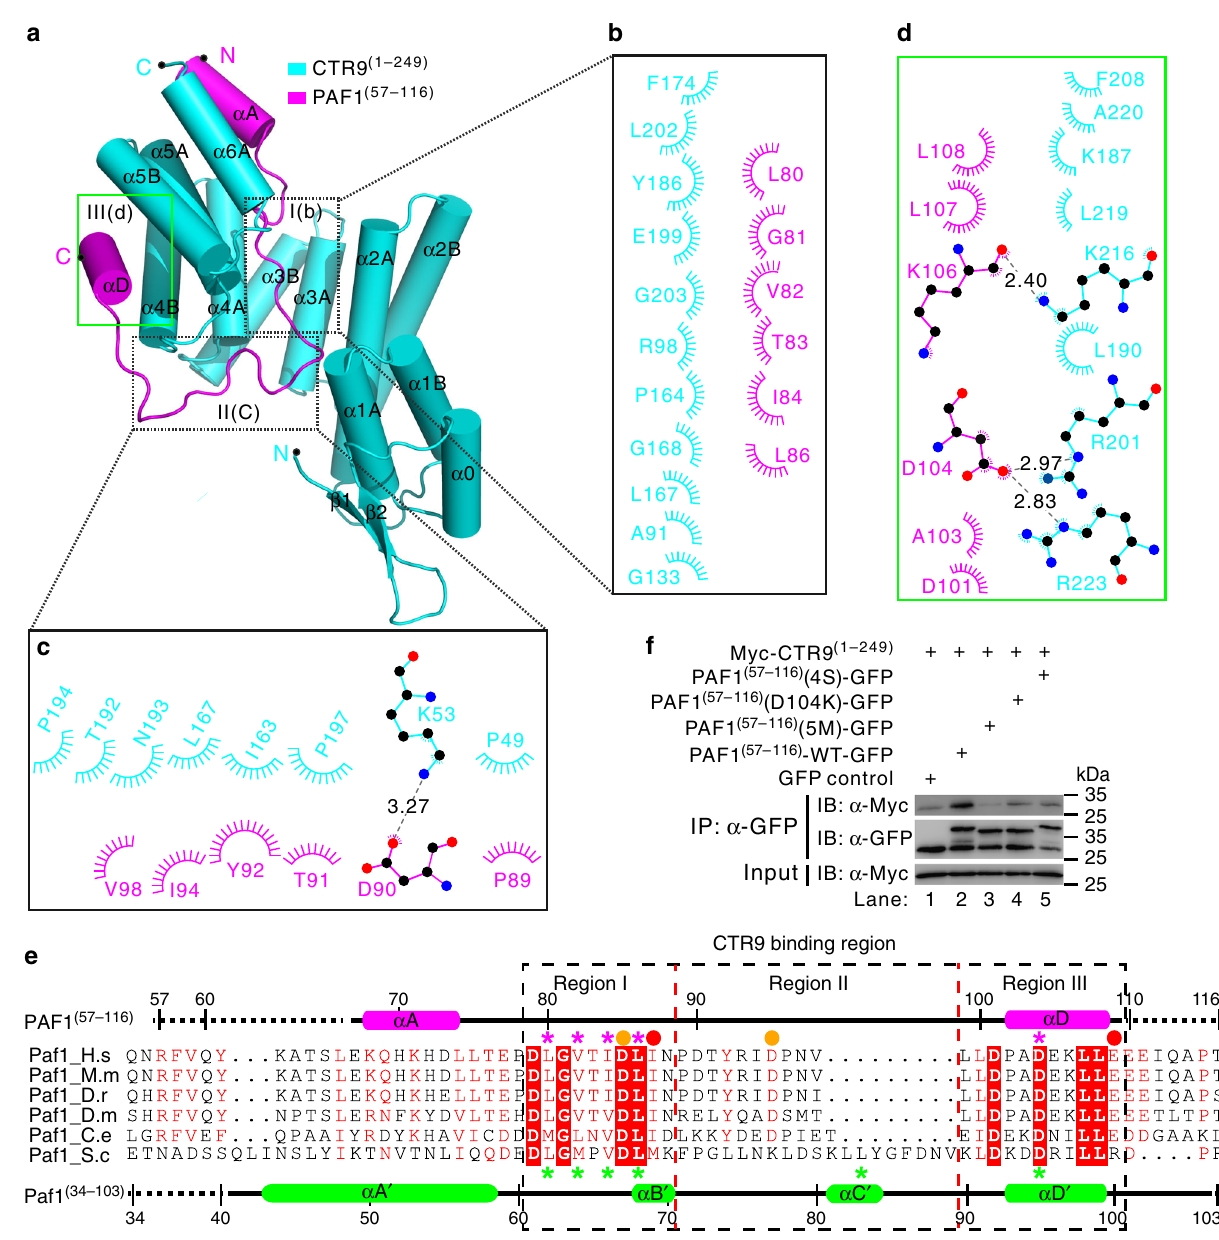
Fig. 2 The interaction interface of the human CTR9/PAF1 heterodimer. a – e The CTR9 (1 – 249) /PAF1 (57 – 116) interface is divided into three regions corresponding to the CTR9 TPR1 – 5 concave channel/N-terminal loop of PAF1 ( b , e ), the side of the TPR1 – 5/C-terminal loop of PAF1 ( c , e ), and the convex surface of the TPR4 – 5/ α D helix of PAF1 ( d , e ). The interaction details between CTR9 and PAF1 in the three regions are shown in ( b ) to ( d ). Charge – charge or hydrogen-bonding and hydrophobic interactions are shown as gray dotted lines and spoked arcs, respectively. e Structural-based sequence alignment of the CTR9-binding fragments of PAF1 in various species. In this alignment, the secondary structures of human PAF1 and yeast Paf1 are shown at the top and bottom, respectively, according to the crystal structures of CTR9 (1 – 249) – PAF1 (57 – 116) and Ctr9 (1 – 313) – Paf1 (34 – 103) , and conserved residues are shaded in red. The highly conserved residues, which are mutated in PAF1 (57 – 116) (4S), PAF1 (57 – 116) (D104K), or PAF1 (57 – 116) (5M) and the Paf1(4S), Paf1(L83S) or Paf1 (D95K) construct, are indicated with magenta and green asterisks, respectively. The disease-associated amino acid substitutions I87M or E109K (category 1 shown in Fig. 3a) and D85N or D95Y (category 2 shown in Fig. 3a) are indicated with red and orange spheres, respectively. Three regions of